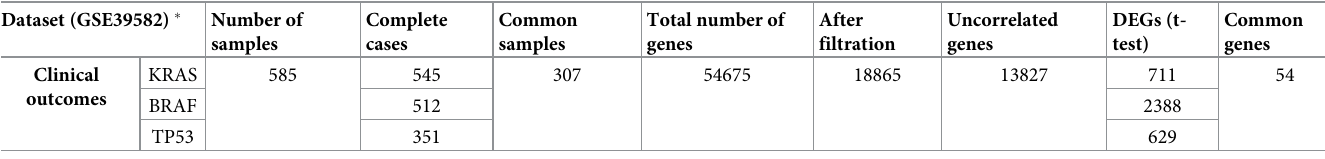
� Three datasets with the same covariates and different clinical